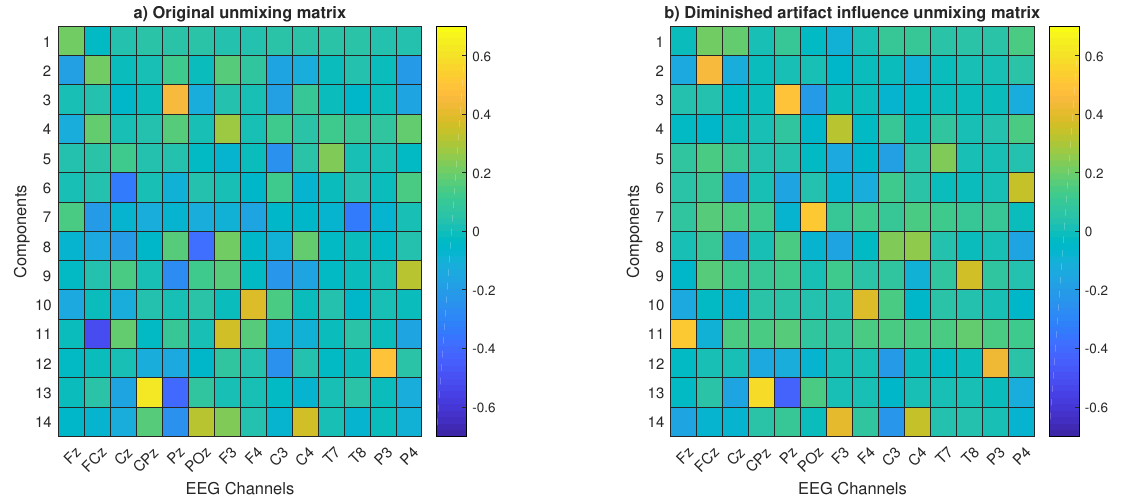
Figure 11. ( a ) Unmixing matrix for ICA decomposition. ( b ) Unmixing matrix for ICA decomposition obtained from data with the influence of eye-artifacts diminished, for subject S 19 , according to the procedure in Section